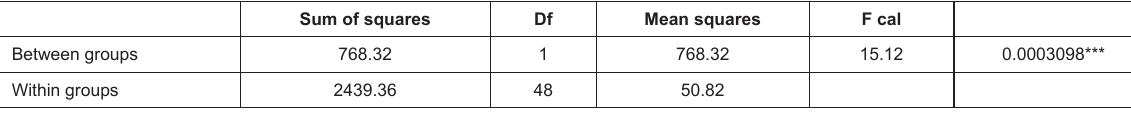
Table 3. Analysis of the data collected on Aerangis biloba in NACGRAB field gene bank Sum of squares Df Mean squares Between